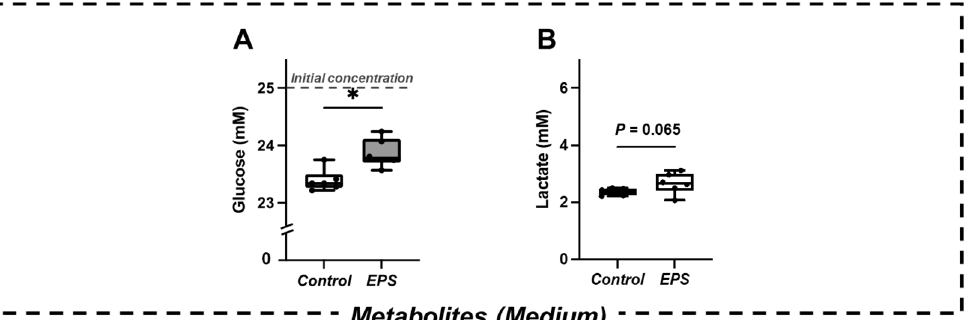
Figure 1. Changes in the concentration of metabolites (( A ) glucose and ( B ) lactate) in the culture medium ( n = 6). The initial concentration of glucose in the culture medium was 25 mM. Values are presented as the median (horizontal line in the box), range between 25th and 75th quartiles (box), and maximum and minimum values (whisker). * Significant difference between groups ( p < 0.05).